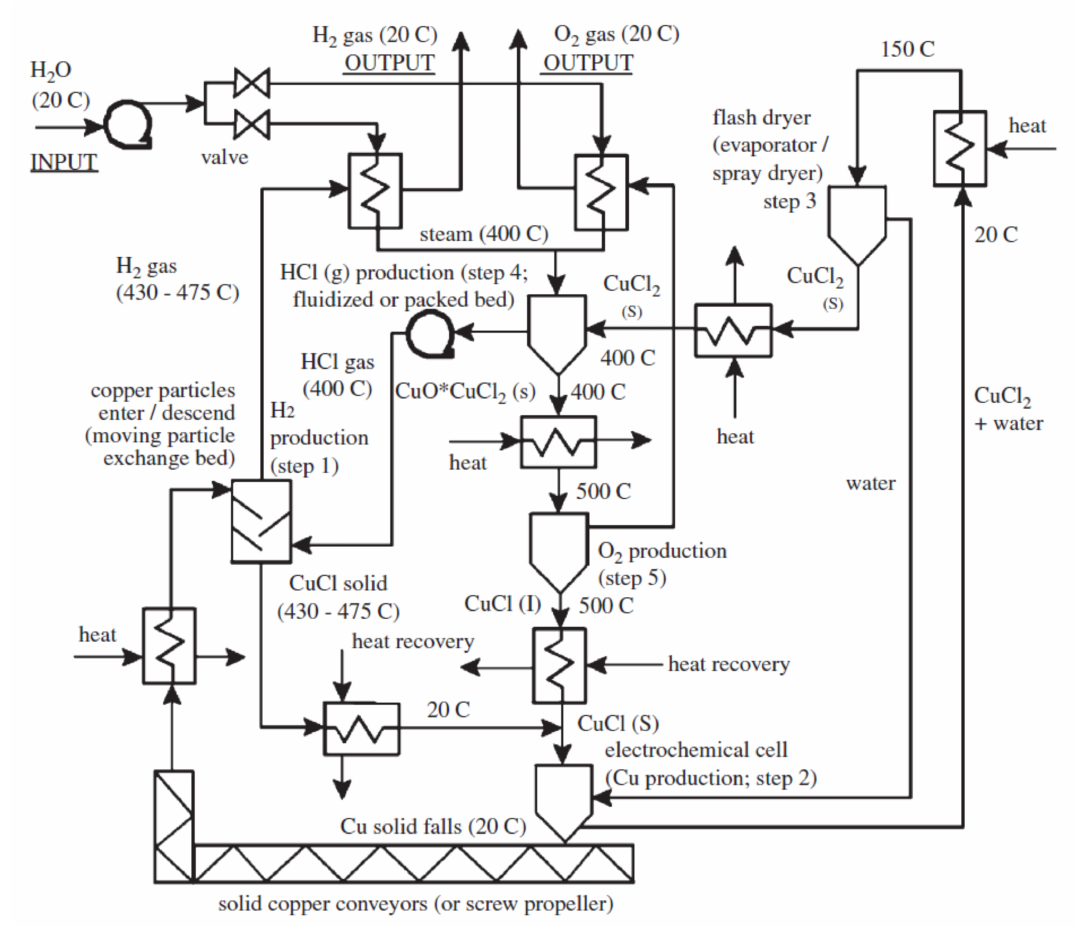
Figure 4. Schematic of the copper-chlorine cycle for hydrogen production